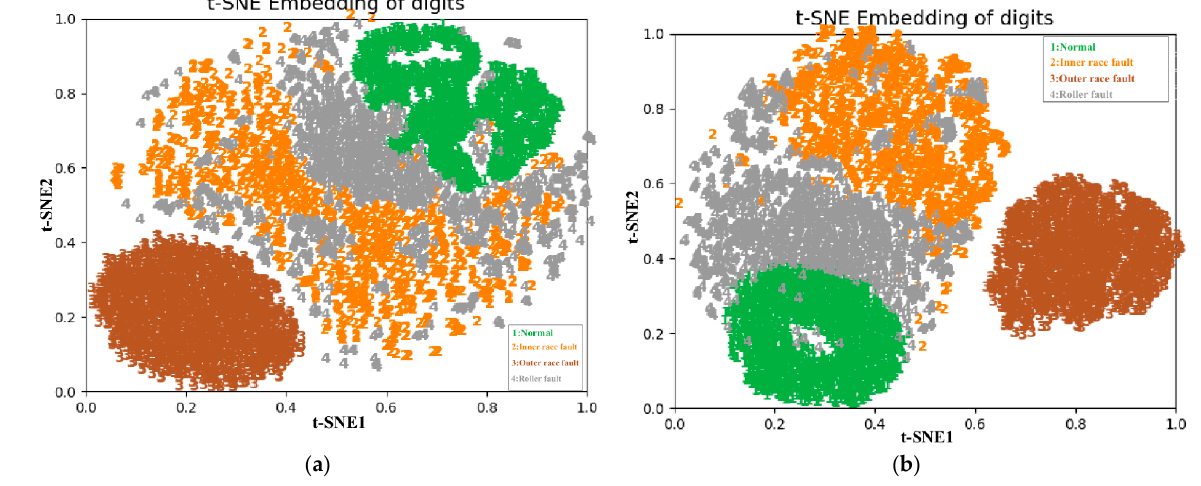
Figure 6. Feature visualization. ( a ) Features extracted by SAE; ( b ) Features extracted by MRAE. Table 4. Fault diagnosis results of experiments 1–6.